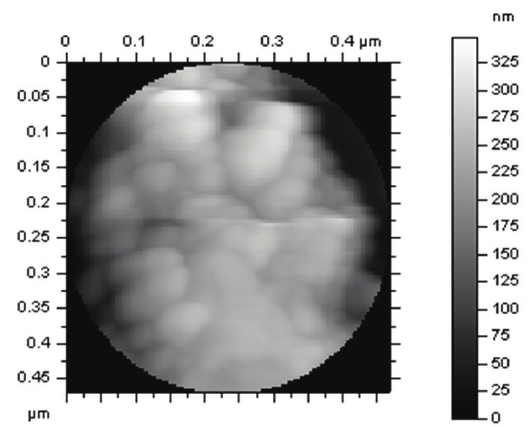
Figure 2. AFM of ZnAl